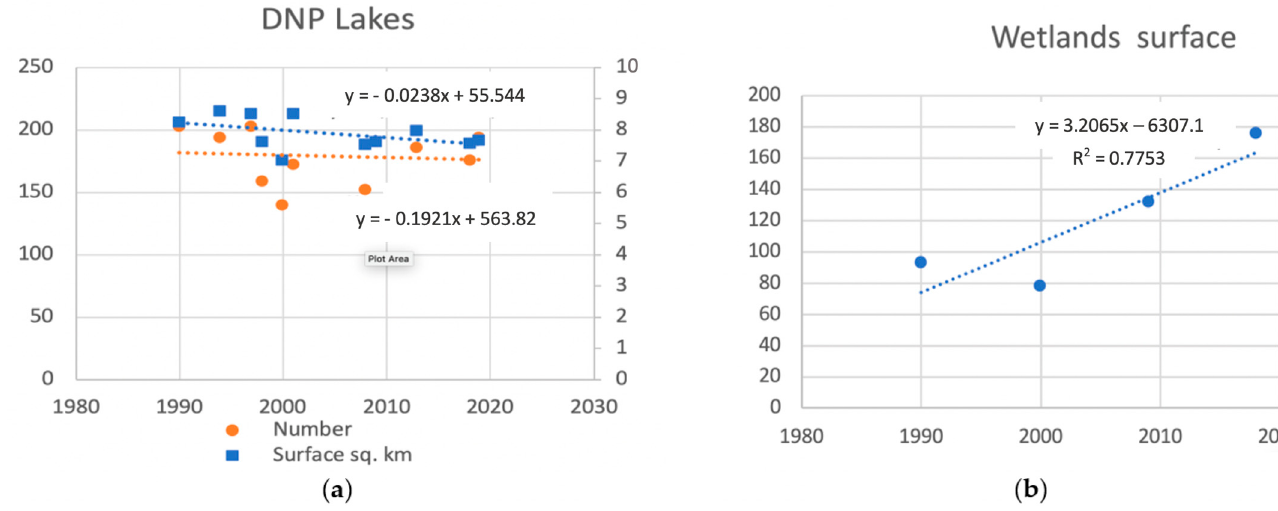
Figure 8. ( a ) Distribution of the number and surfaces of the lakes extracted from the Landsat series. ( b ) Surfaces of the wetlands obtained from the four Landsat images in Table 4.